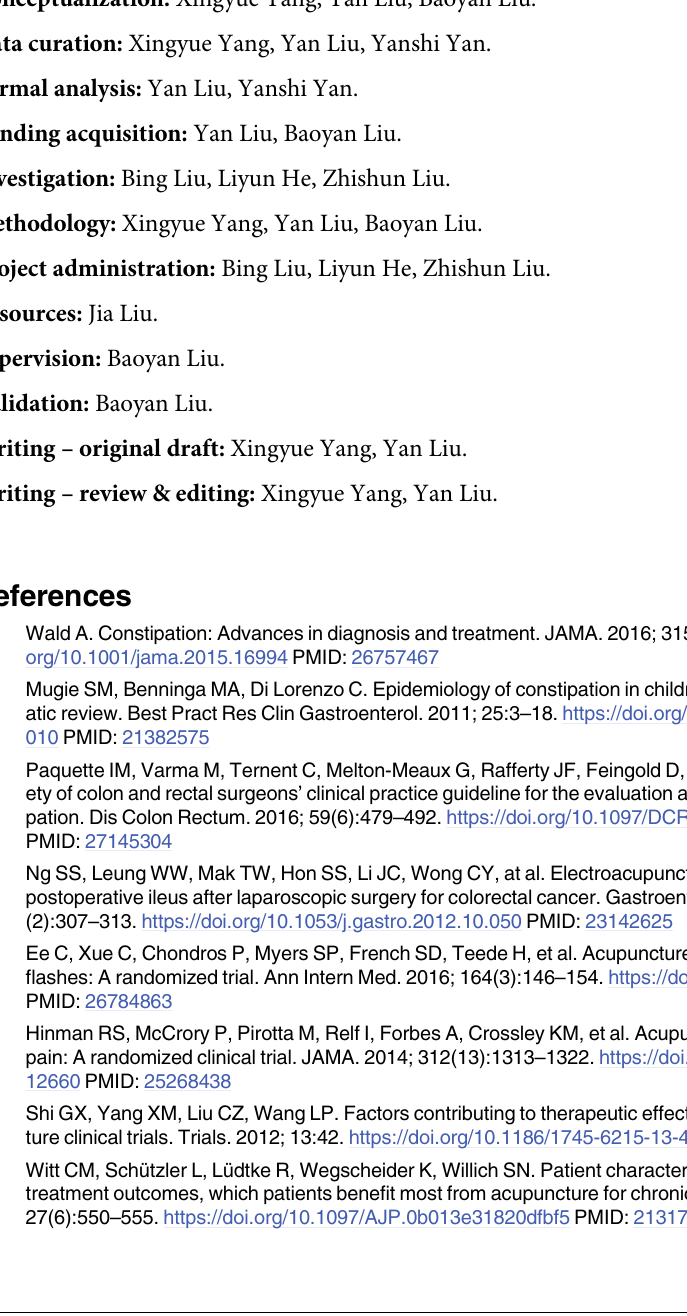
S1 Table. CSBM responder rate from week 1 to week 20. S2 Table. CONSORT